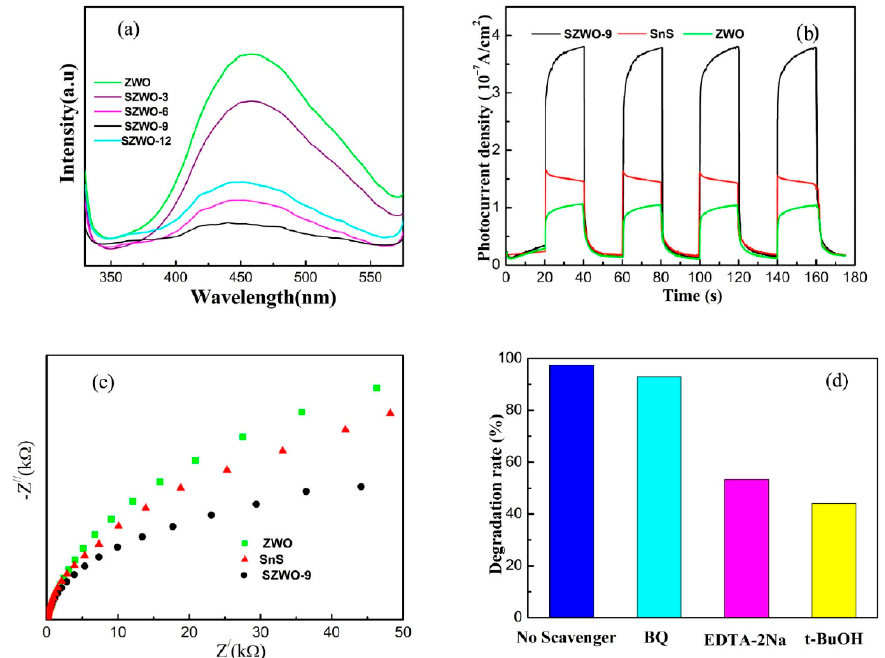
Figure 8. ( a ) PL spectra of ZWO and SnS/ZWO hybrid composites, ( b ) transient photocurrents and ( c ) electrochemical impedance spectra of ZWO, SZWO-9 and SnS electrodes under visible light irradiation; ( d ) effect of various scavengers on the visible light photocatalytic performance of the SZWO-9